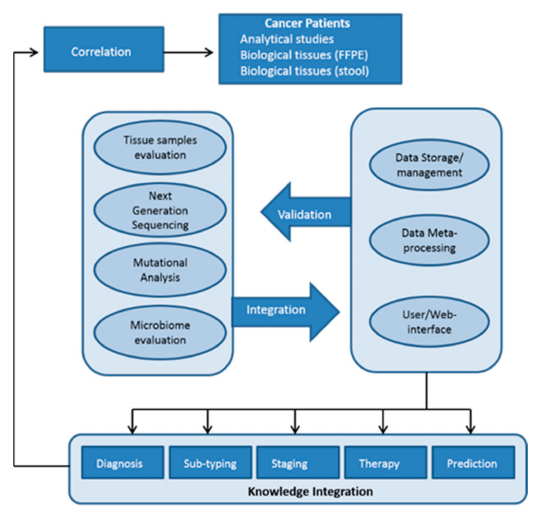
Figure 2. Graphical presentation of the tasks showing the way they inter-relate (Pert